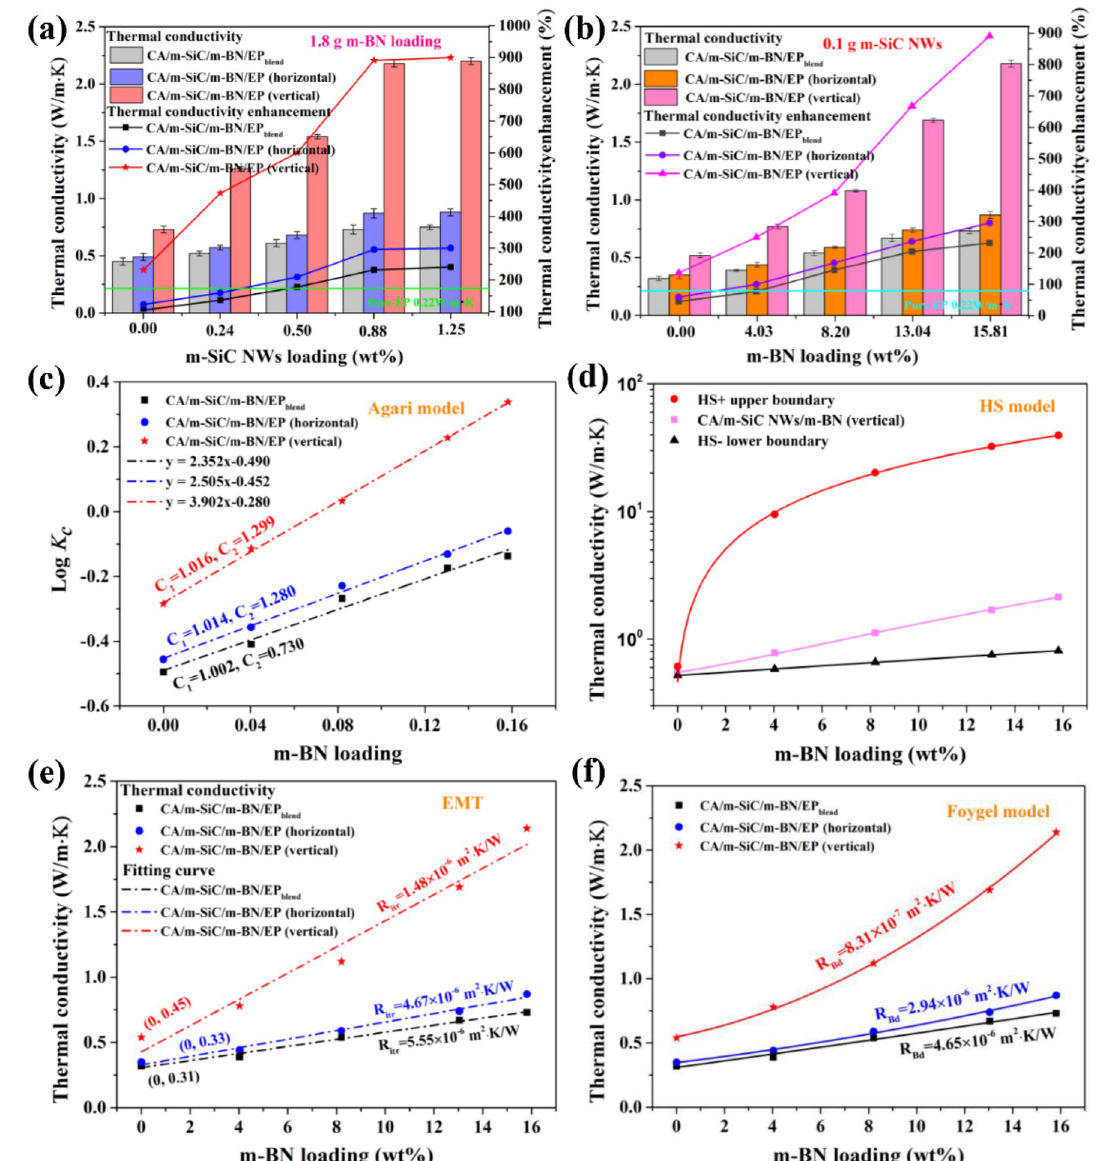
Fig. 6 Anisotropic thermal properties analysis of CA/m‑SiC/m‑BN/EP. a Thermal conductivities and thermal conductivity enhancements of CA/m‑SiC/m‑BN/EP and CA/m‑SiC/m‑BN/EP blend composites with different m‑SiC NW S contents at the m‑BN mass of 1.8 g. b Thermal con‑ ductivities and thermal conductivity enhancements of CA/m‑SiC/m‑BN/EP and CA/m‑SiC/m‑BN/EP blend composites with different m‑BN con‑ tents at the m‑SiC NW S mass of 0.10 g. c Agari model fitting lines, d Hashin–Shtrikman (HS) model fitting lines, e EMT model fitting lines and f Foygel’s theory fitting lines of CA/m‑SiC/m‑BN/EP and CA/m‑SiC/m‑BN/EP blend